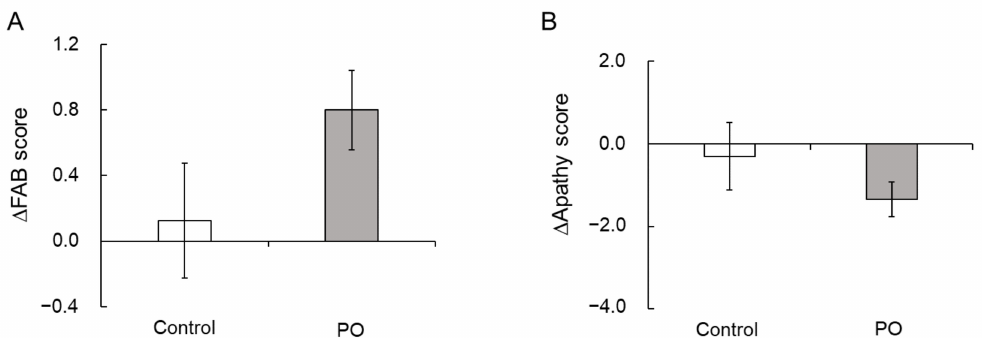
Figure 2. Effect of PO-intake on FAB and apathy scores. Mean changes ( ∆ ) in the FAB scores ( A ) and apathy scores ( B ) after 12 months of intervention in the PO and control groups. Bar represents mean ± SE. PO, perilla seed oil; FAB, Frontal Assessment